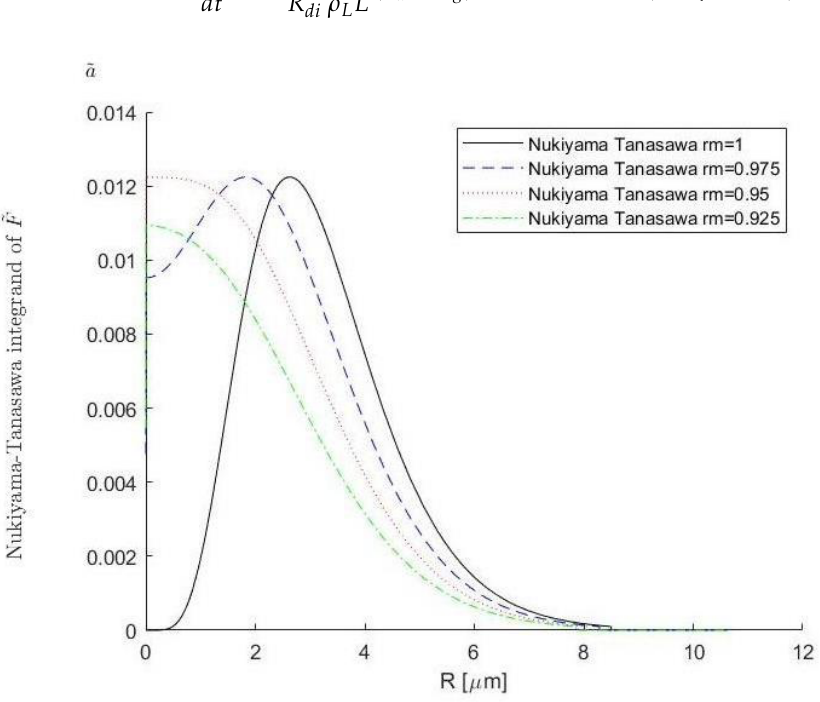
Figure 6. Nukiyama–Tanasawa integrand of ˜ F given by Equation (13) for various values of r m